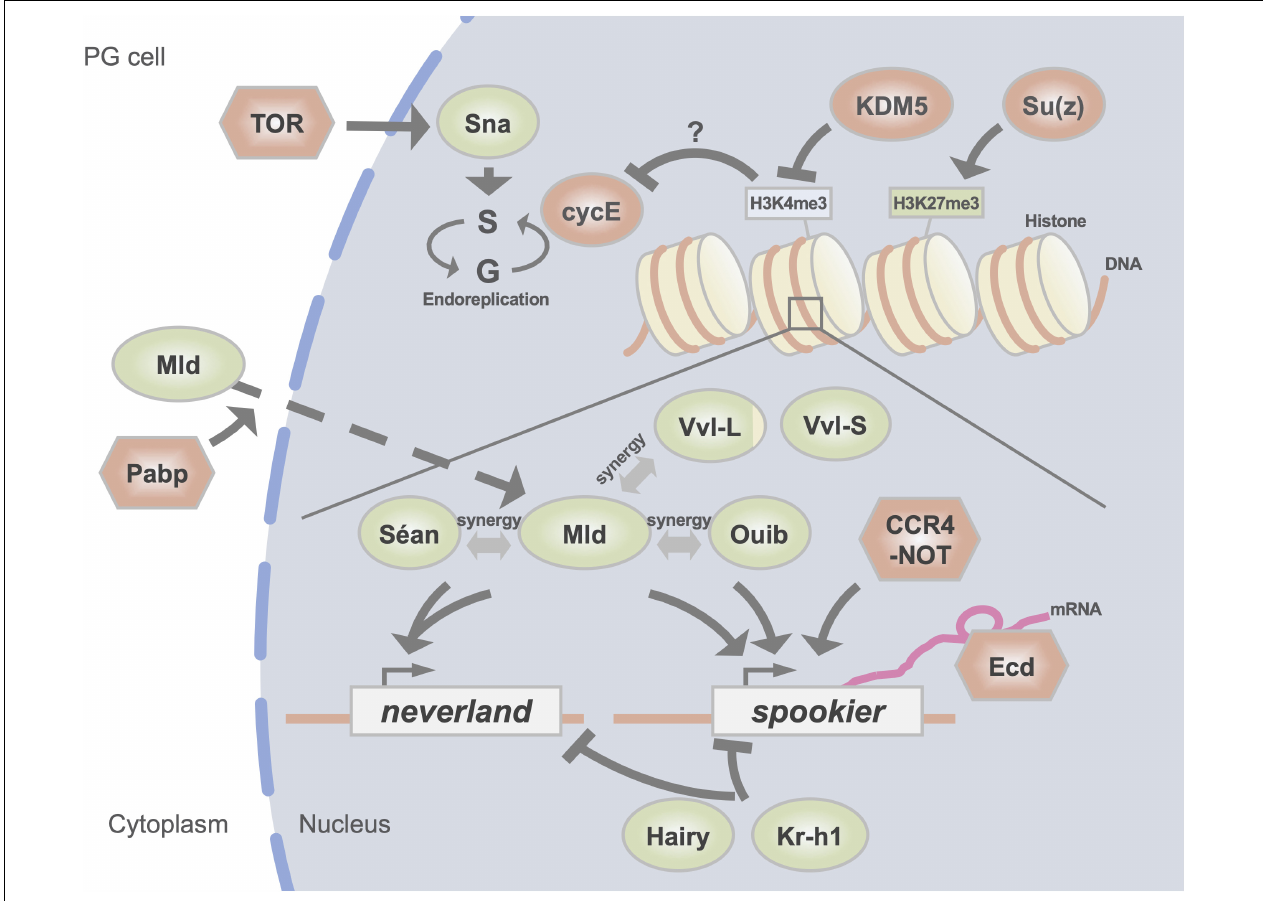
FIGURE 2 | A schematic illustration of regulators of the expression of Halloween genes in the PG. DNA-binding transcription factors are indicated in green circles. Red circles represent histone modification enzymes and cell cycle regulators. Other factors are indicated in red hexagons. H3K4me3 and H3K27me3 indicate trimethylation of the fourth and 27th lysine residues of histone H3,